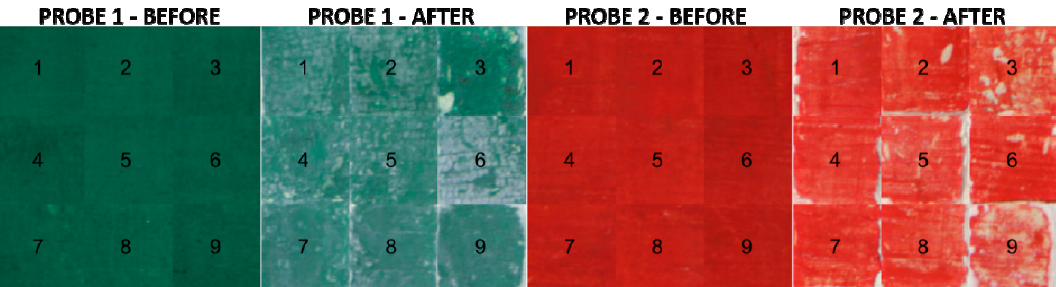
Figure 4. sRGB renderization of the 100 × 100 pixel areas extracted from all the samples both before and after the cleaning